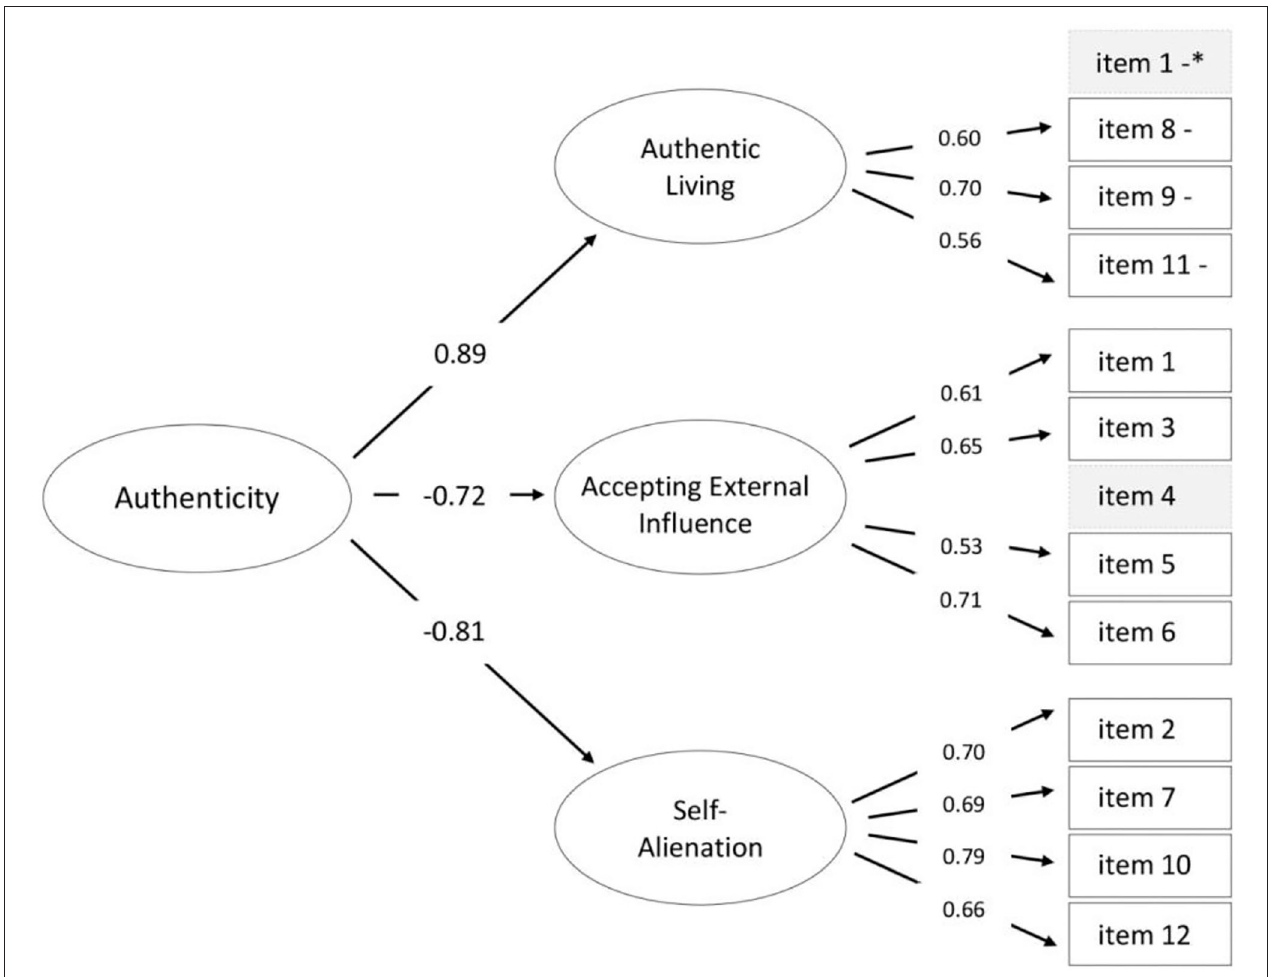
FIGURE 3 | The optimal CFA model tested for the Authenticity Scale compared with the original model (Wood et al., 2008). Blocks dotted gray indicate excluded items. * – item one was included in Accepting External Influence. “–” indicates negatively phrased items. Error variances omitted for